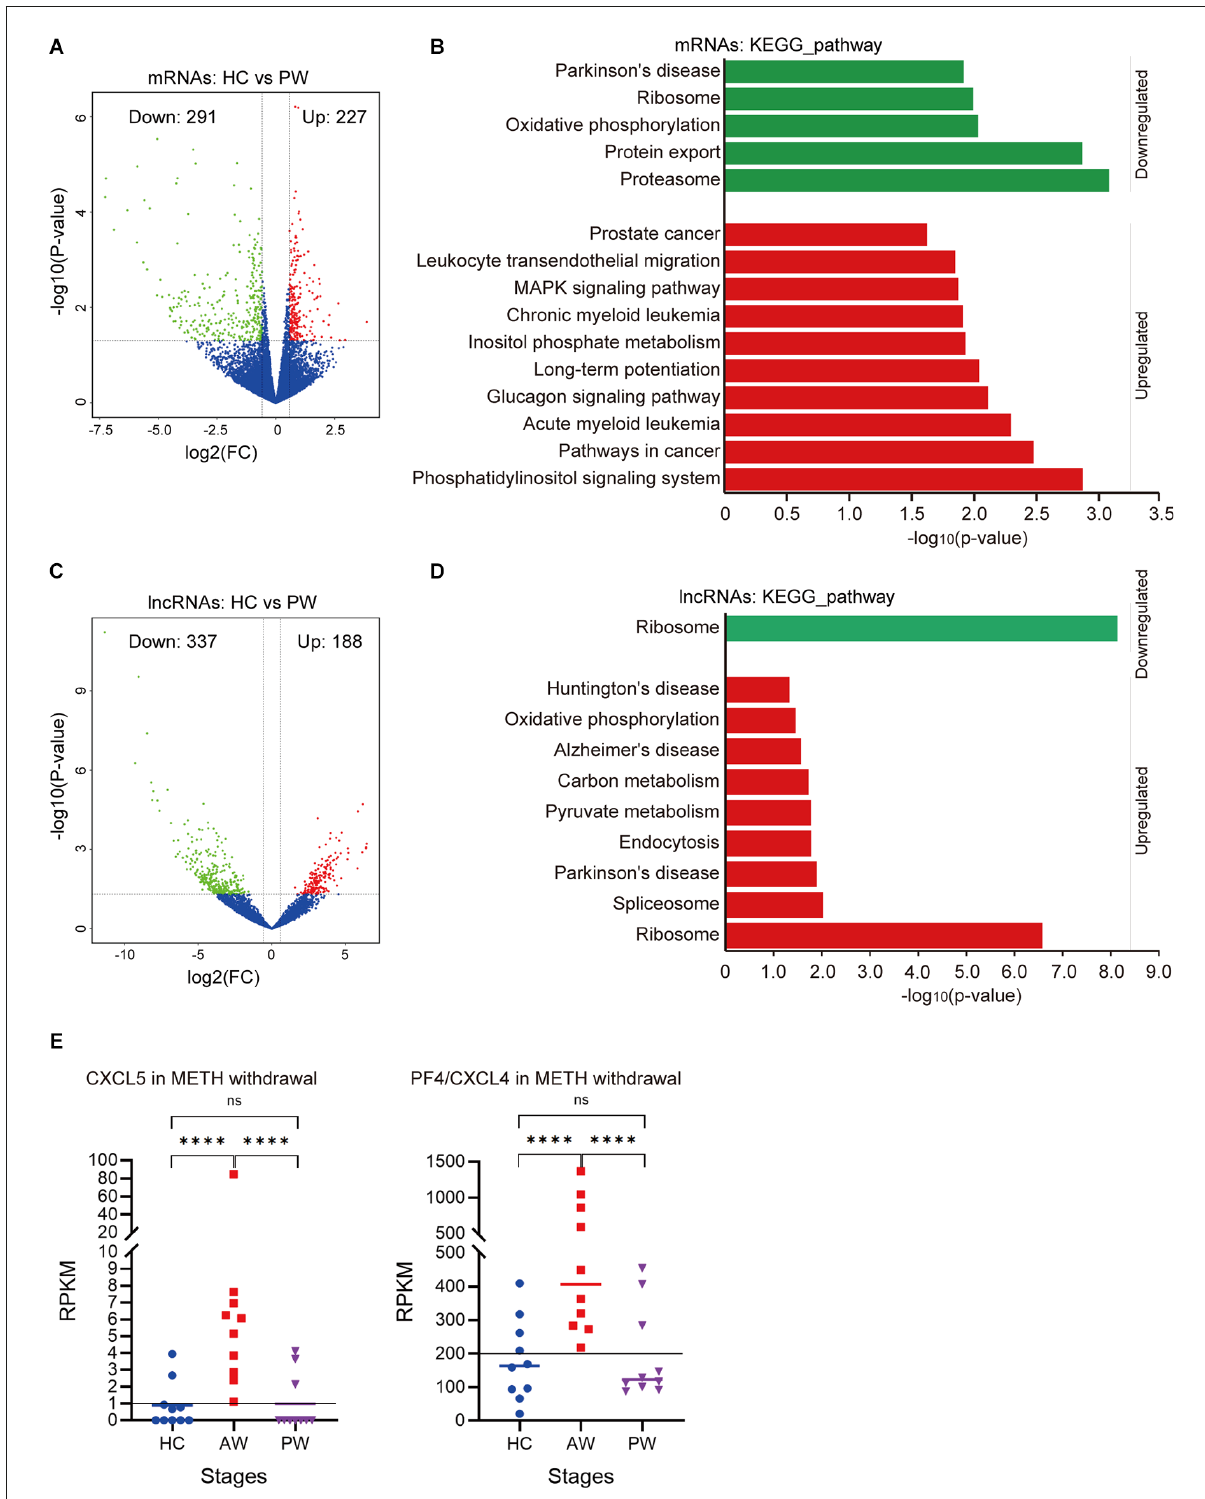
FIGURE3 Potential expression profile differences at the AW stage and protracted METH withdrawal (PW) stage. (A) Volcano plot showed the DE mRNAs at the PW stage. (B) DAVID-KEGG analysis of DE mRNAs at the PW stage. (C) Volcano plot showed the DE lncRNAs at PW stage. (D) DAVID-KEGG analysis of DE lncRNAs at the PW stage. Green represents downregulated genes; Red represents upregulated genes. lncRNA, long noncoding RNA. (E) Potential biomarkers (CXCL5, CXCL4) in the AW stage exosomal transcriptome. **** p < 0.0001; ns, no significant